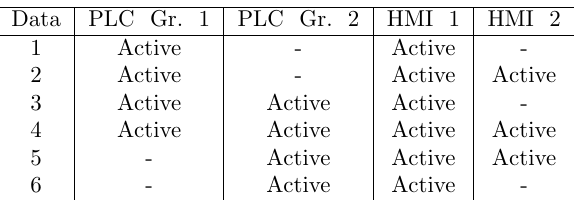
Figure 1. Simplified HEDVa networking architecture